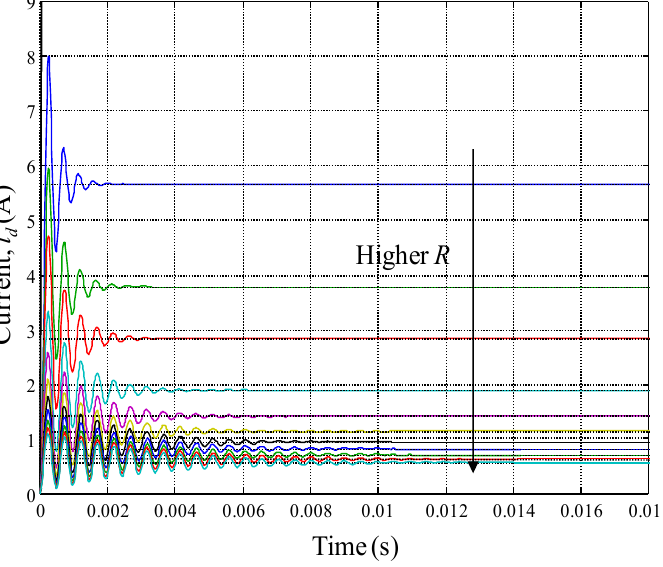
Figure 2. Time response of the plant when a unity step of m is applied at different d operation points ( R , 1.5 R , 2 R , 3 R , 4 R , 5 R , 6 R , 7 R , 8 R , nom nom nom nom nom nom nom nom nom 9 R , 10 R ). nom nom